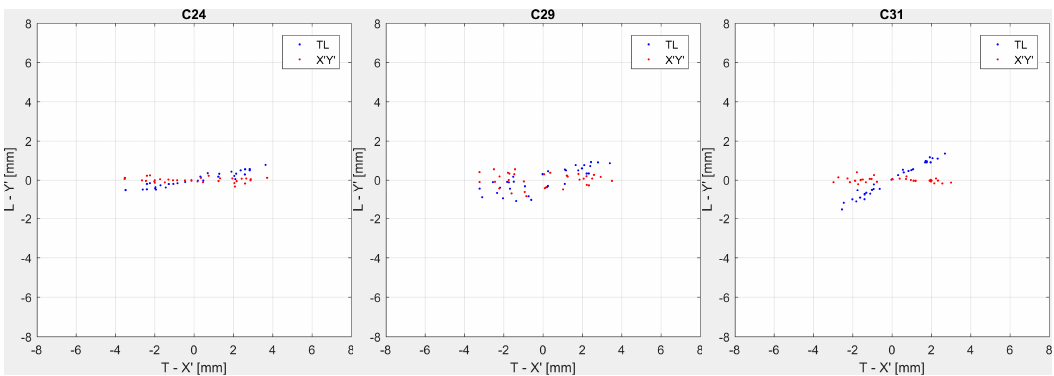
Figure 5. Displacements observed on ashlars 24 ( left ), 29 ( center ), 31 ( right ) by pendulums in the T-L (blue dots) and X ′ -Y ′ (red dots) reference systems from 10 December 2014 to 9 December 2015.